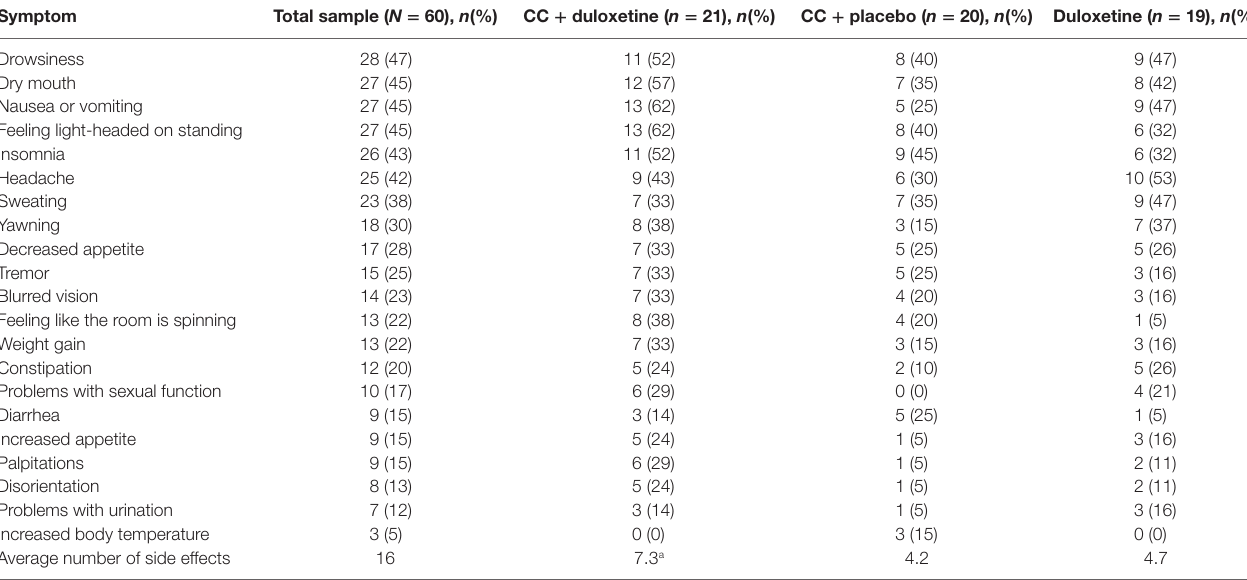
TaBlE 5 | Number of patients who reported side effects of duloxetine/placebo measured with the ASEC-21. Symptom